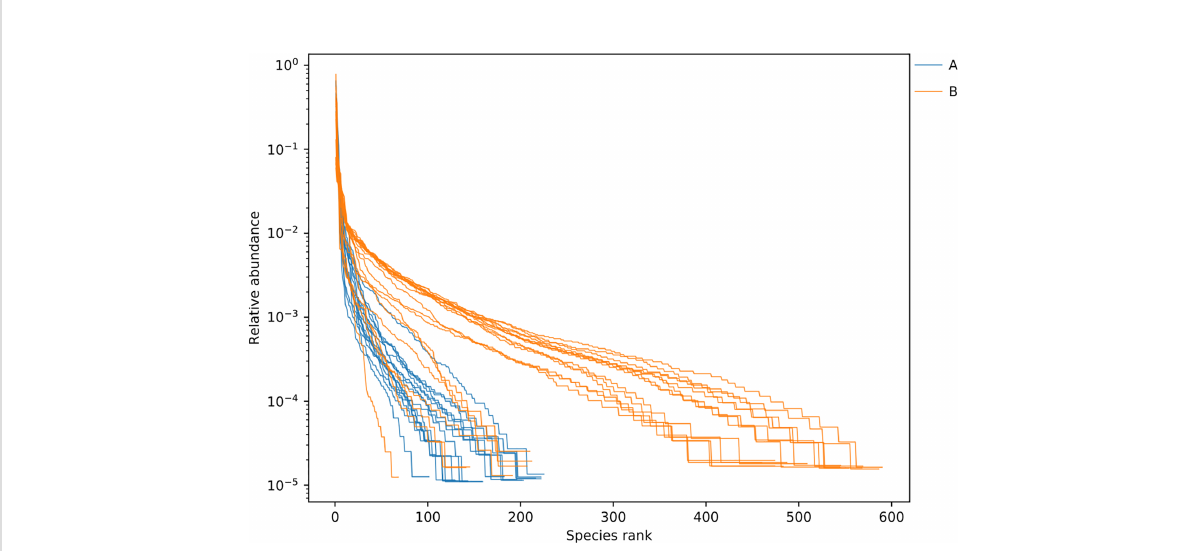
FIGURE 5 Rank abundance curve between samples of LRTI children with/without hematological malignancies. Curve A re fl ects BALF samples of LRTI children with hematological malignancies; Curve B re fl ects BALF samples of LRTI children without hematological malignancies. Width of each curve means the species richness of certain samples; smoothness means the species evenness of certain